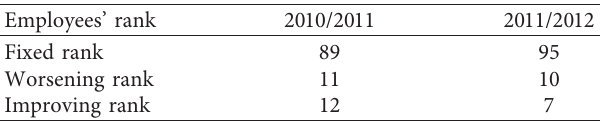
Table 5: Rank story of the employees (real data). Number of employees which changes or does not change their rank during years 2010/2011 and 2011/2012.